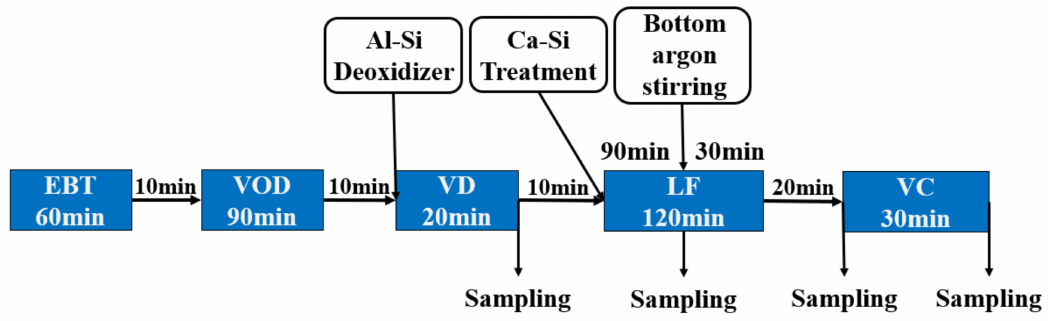
Figure 1. Schematic of sampling